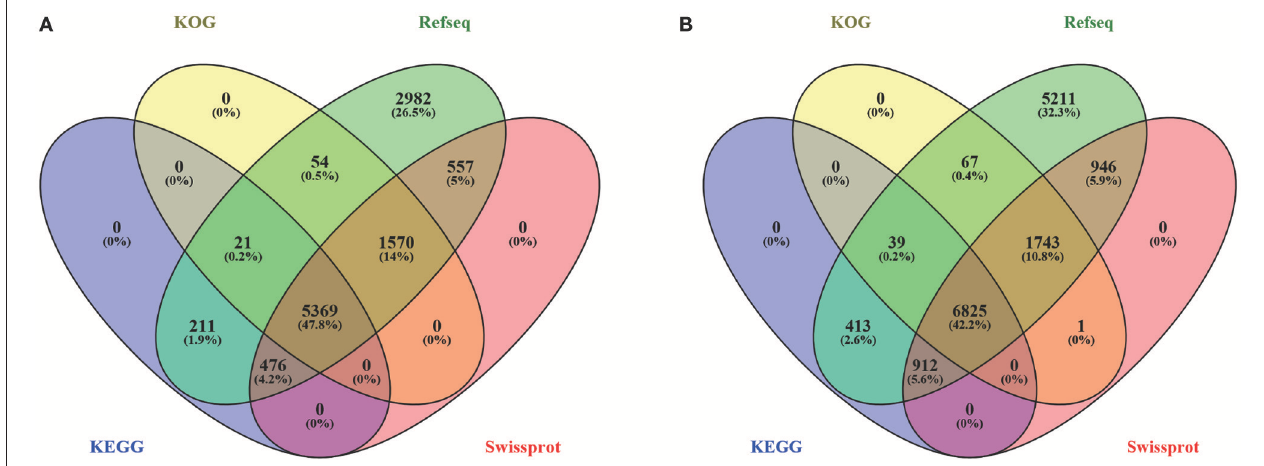
FIGURE 4 | Venn diagram of gene annotation in four databases (KOG, Refseq, KEGG, and Swiss-Prot) of P. polonicum hy4 (A) and C. gloeosporioides Cg01 (B) .